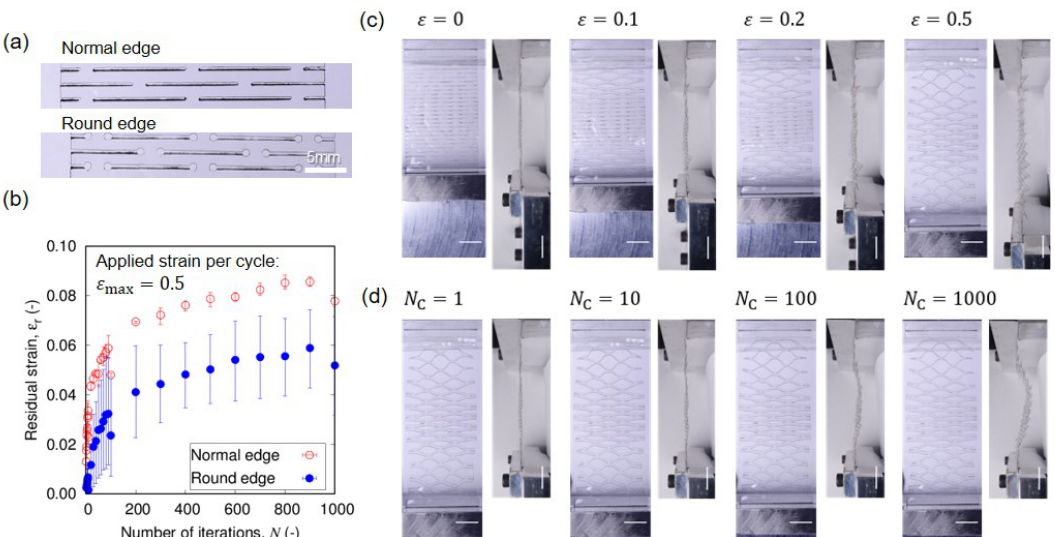
Figure 5. The characteristics of Kirigami design based on the cut lines with round edges: ( a ) Digital camera images of cut lines based on the sharp edge and the round edge on nanopapers. ( b ) Compari- son of residual strain by Kirigami patterns with round edge and normal edge. The scale of Kirigami patterns is s = 3 and the maximum strain is ε max = 0.5. The error bars indicate the maximum and minimum values in the three trials of different specimens. ( c , d ) Sequential snapshots in the tensile tests of Kirigami patterns with round edges with scale parameter s = 3, where ( c ) the tensile loading to ε max = 0.5 without iteration (i.e., N c = 1), and ( d ) iterative tensile loading cycles with ε max = 0.5. The unit pair of subfigures for a specific strain value in ( c , d ) indicate the top and side views of the specimen. It should be noted that side views in ( c ) indicate the tensile state and those in ( d ) indicate the state of the original end-to-end distance, while top views in ( d ) indicate the state of ε max . The scale bars indicate 10